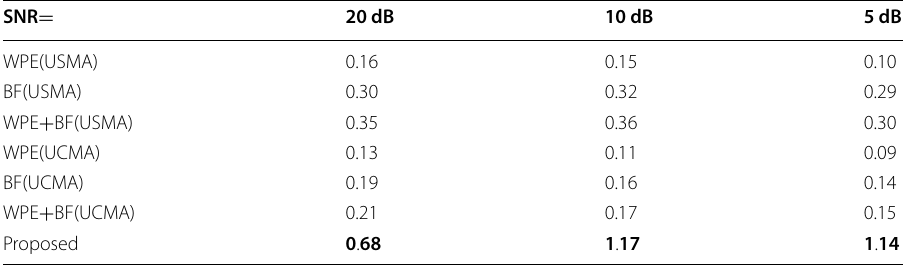
Boldface indicates the best score for each condition The level of diffuse noise and the reverberation time are controlled, confined to 5 –20 dB and 200–1000 ms, respectively. Our primary goal is audio capturing in the high reverberant environments, so in the test scenarios, we divide the diffuse noise levels into three parts: very high noise level (SNR 5 dB), high noise level (SNR 10 dB), and = = medium noise level (SNR 20 dB). =